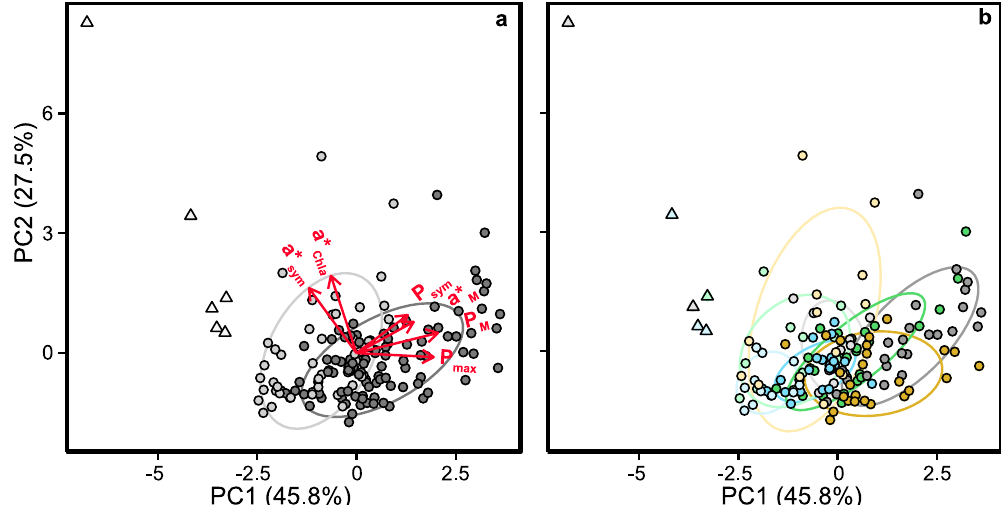
Figure 7. Principal component analysis (PCA) for control and heat-stressed corals. ( a ) grouping of control (dark grey circles), heat-stressed (grey circles) and bleached (light grey triangles) coral phenotypes, based on optical (a * Chl a , a * sym , a * M ) and photo-physiological (P max , P sym , P M ) coral traits. Red arrows indicate the correlation of the different descriptors with PC1 and PC2. ( b ) grouping of control, heat-stressed and bleached corals based on the same descriptors per species: O . annularis (blue), O . faveolata (orange), M . cavernosa (green), and P . strigosa (red). Different shading illustrates differences from unstressed (dark) to bleached (lighter) phenotypes.